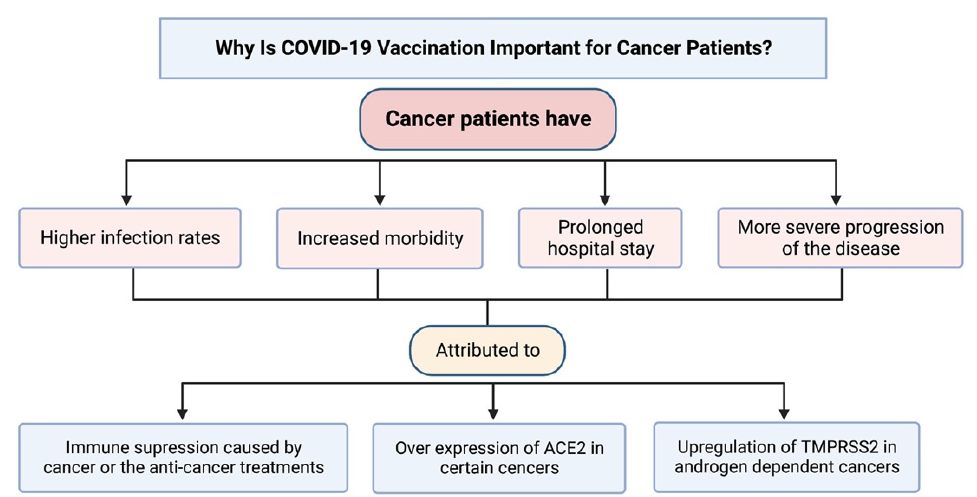
Figure 1. Reasons supporting the importance of COVID-19 vaccination in cancer patients, and mechanisms attributed to cancer patients’ increased susceptibility, severity, and morbidity from COVID-19 disease.